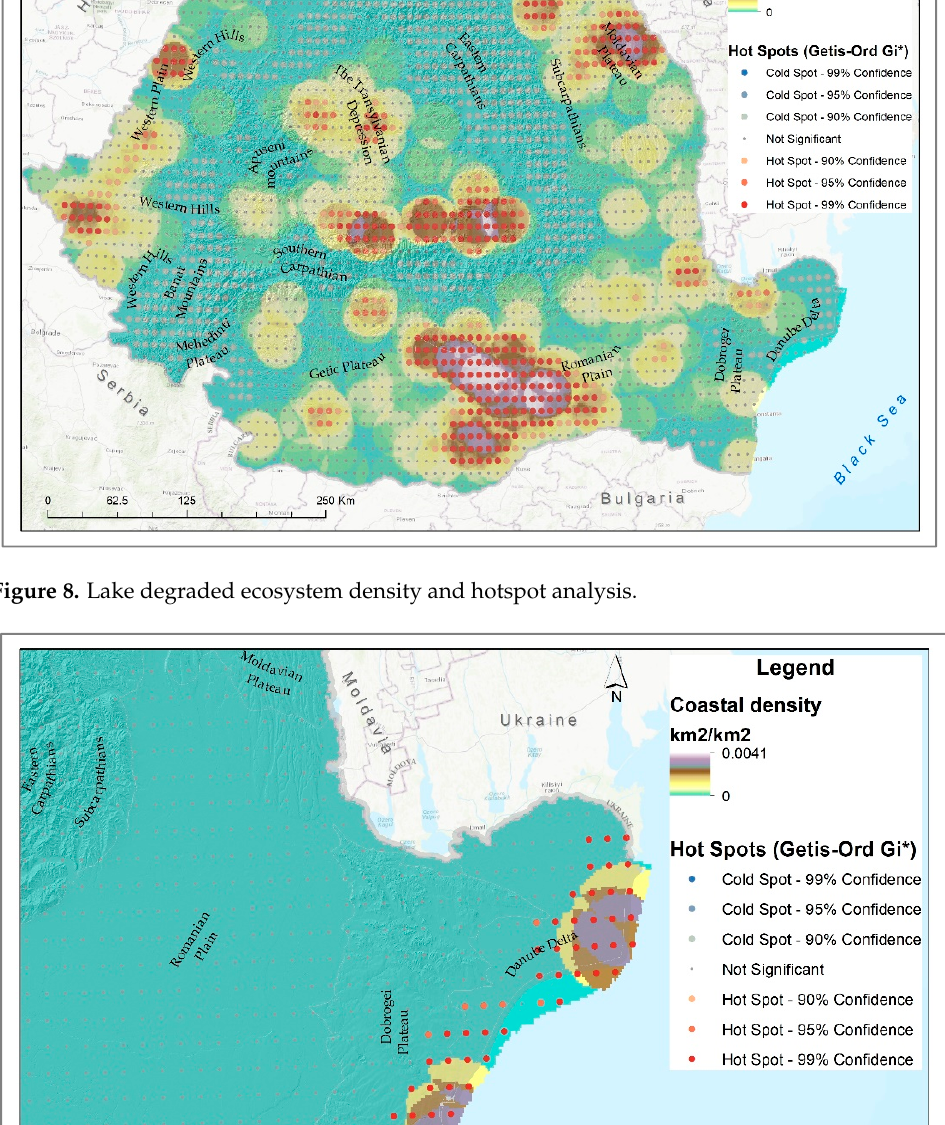
Figure 8. Lake degraded ecosystem density and hotspot analysis.